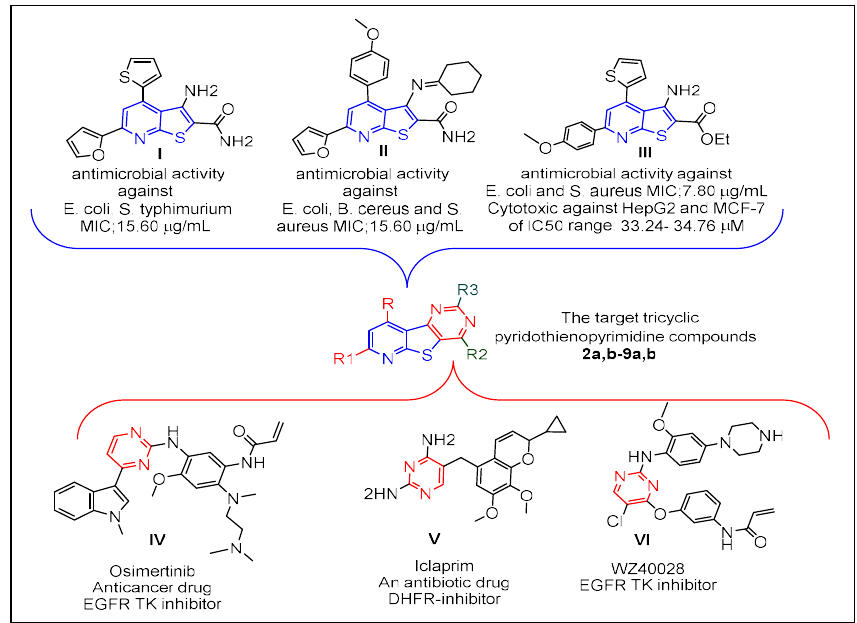
Figure 1. Reported thienopyridines ( I – III ) and pyrimidines ( IV – VI ) effective as antimicrobial and/or anticancer agents, and design of the new pyridothienopyrimidine compounds.